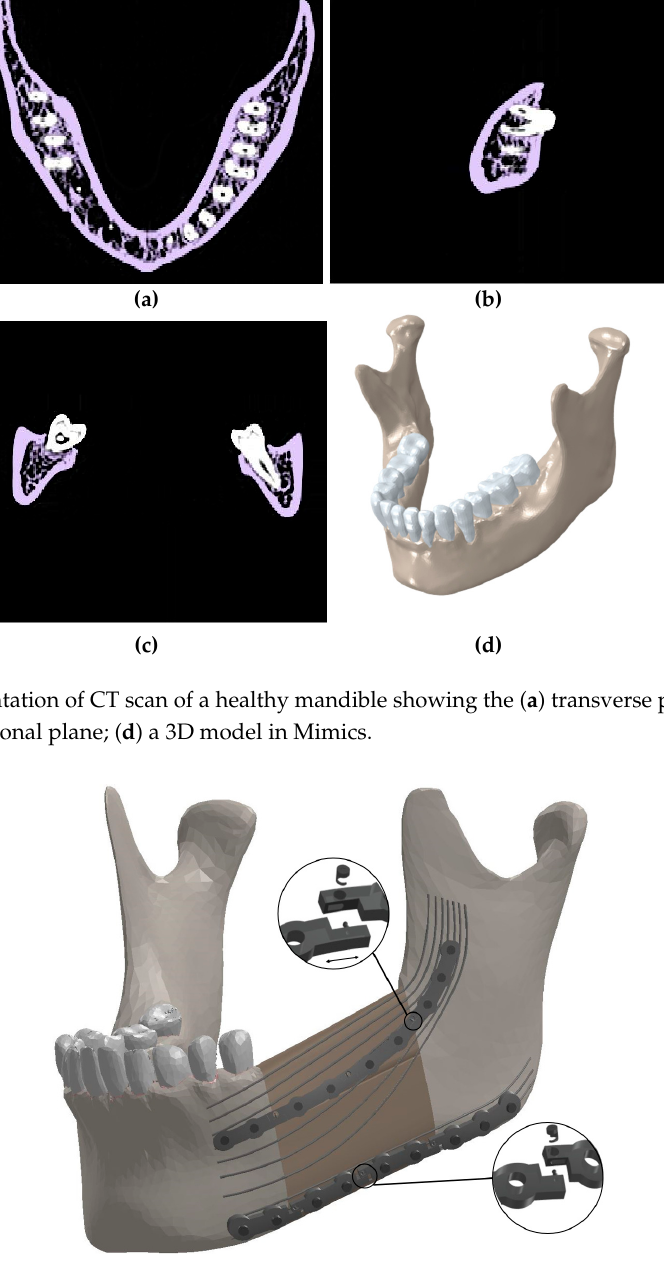
Figure 2. The components of the Bone Bandaid mandibular reconstruction using a releasable